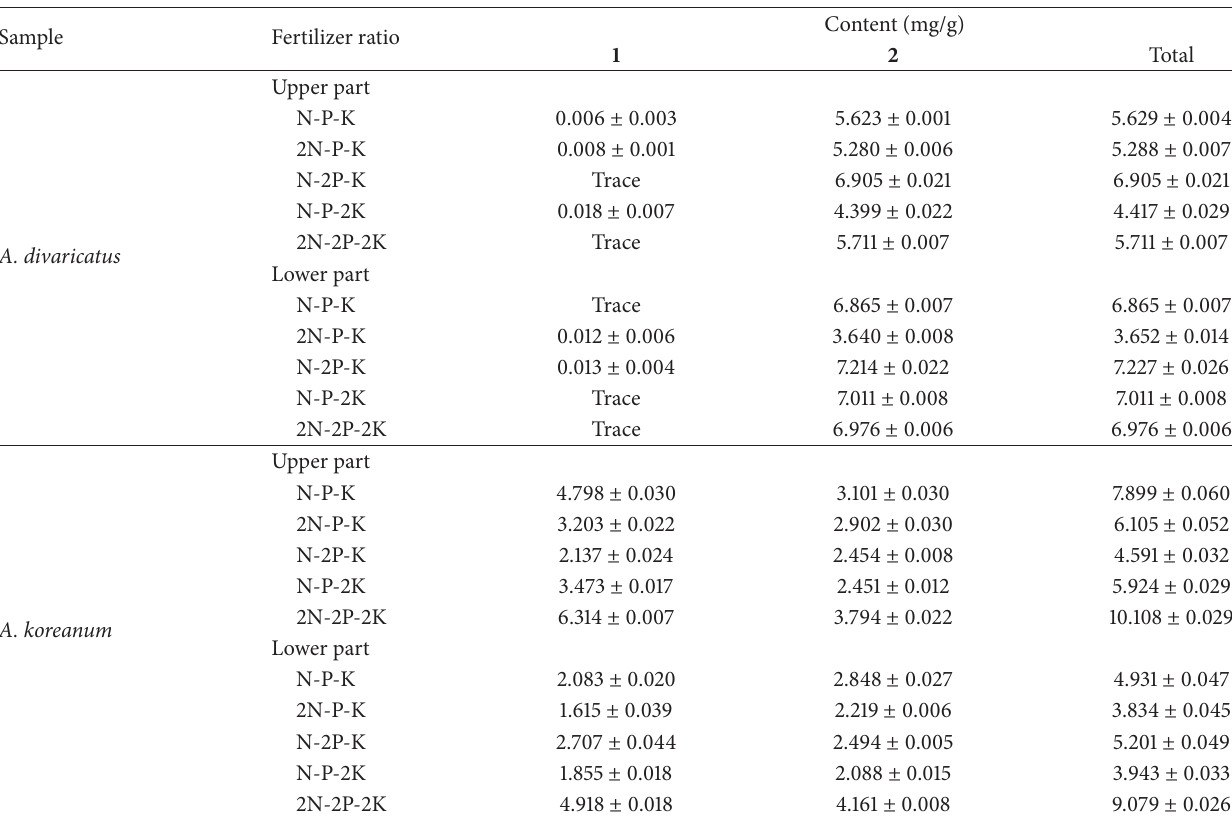
Table 4: The contents of eleutherosides B ( 1 ) and E ( 2 ) in A. divaricatus and A. koreanum cultivated with varying fertilizer ratio.